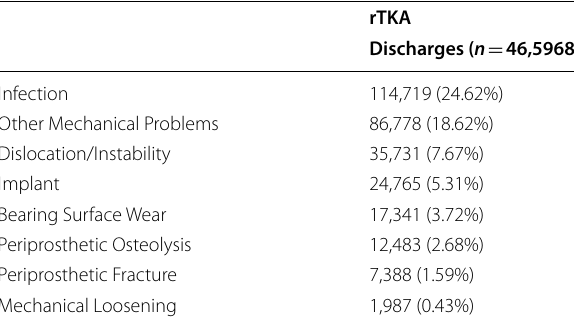
Table 5 Indications for rTKA collected from the NIS database from 2006 to the third quarter of